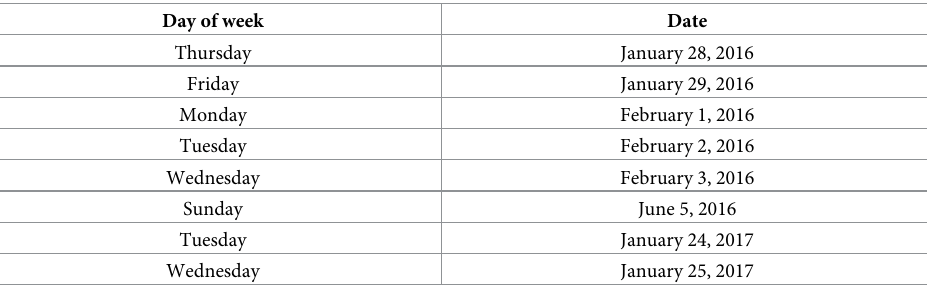
Table 4. List of days detected as